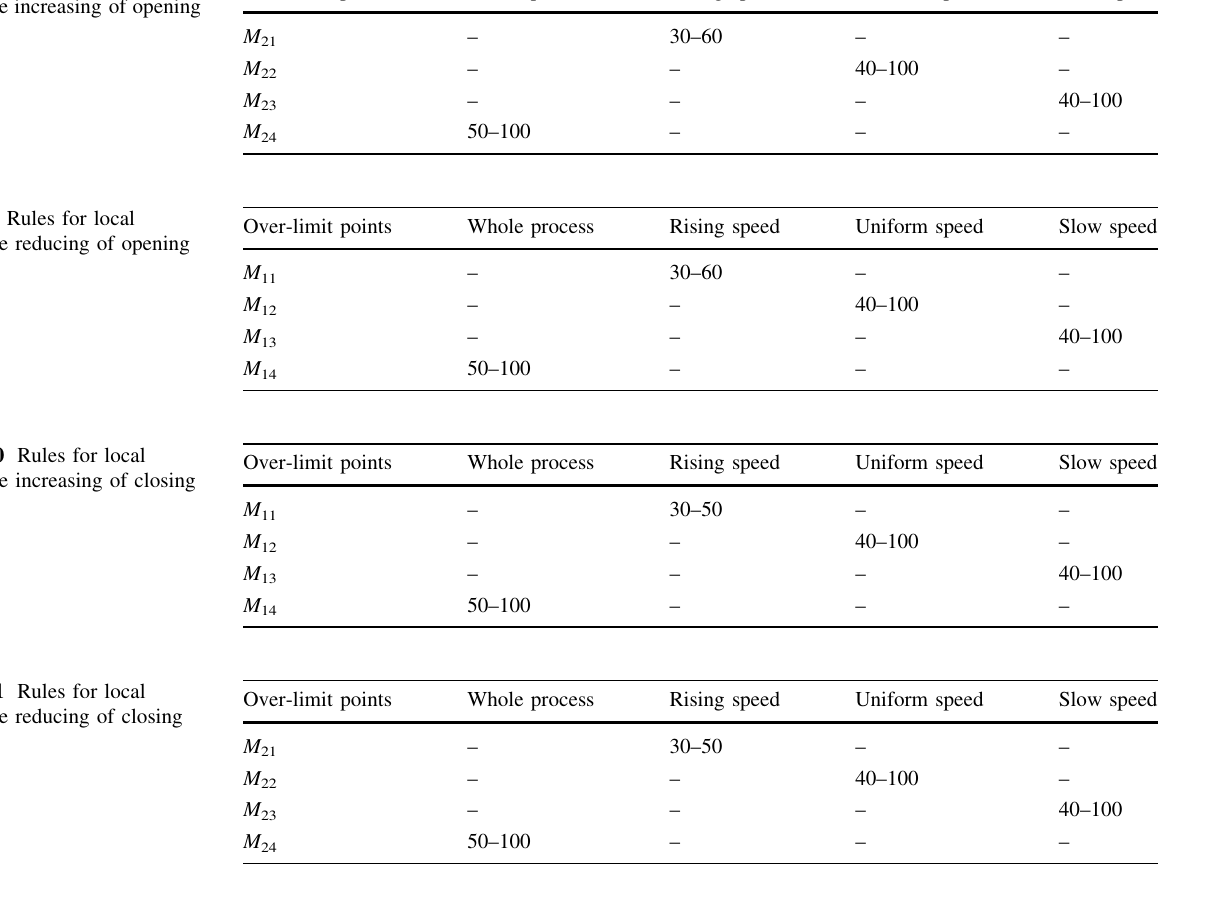
resistance increasing of opening door